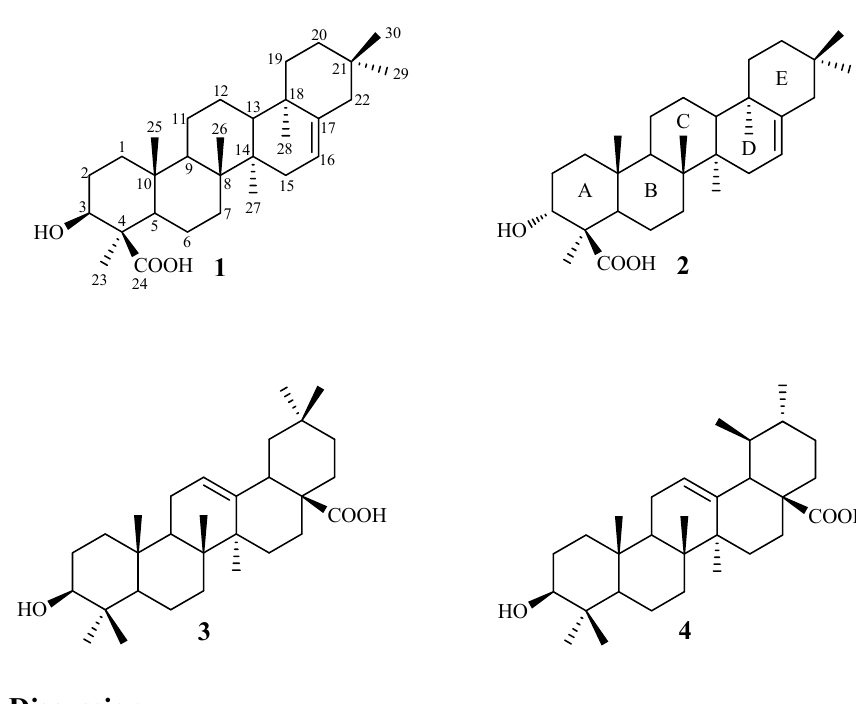
Figure 1. Structures of compounds 1 – 4